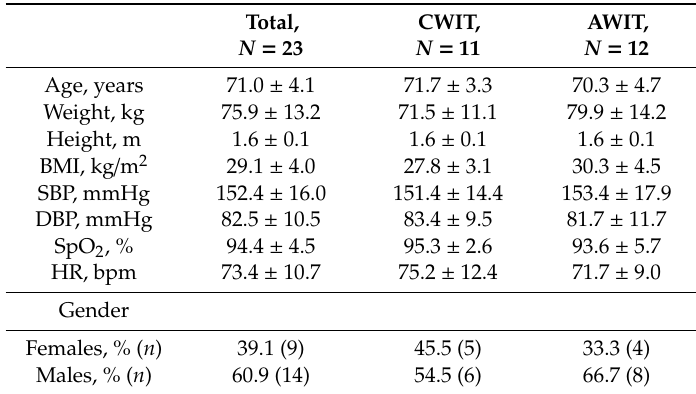
Table 2. Physical characteristics at baseline.